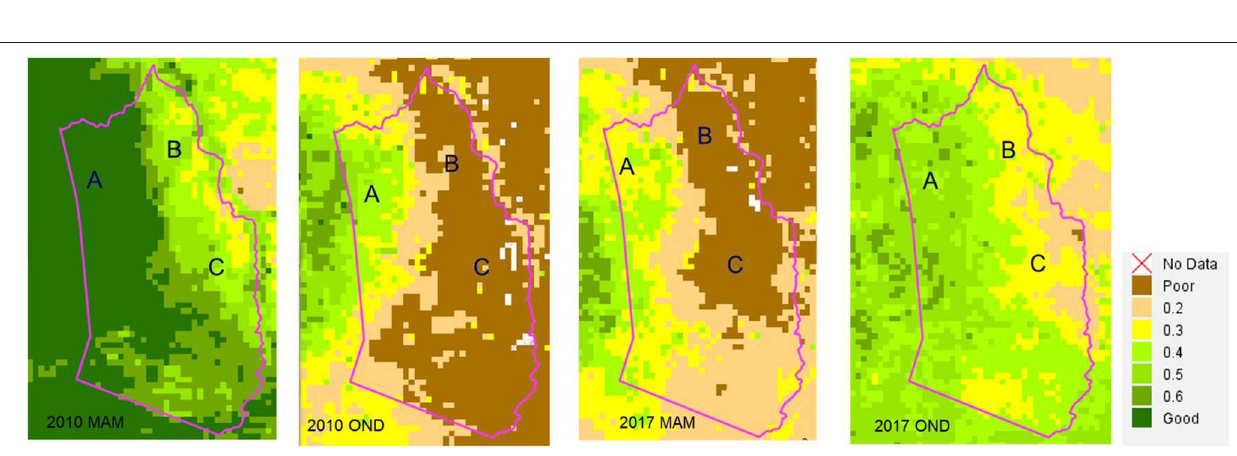
vegetation productivity decline over time has been